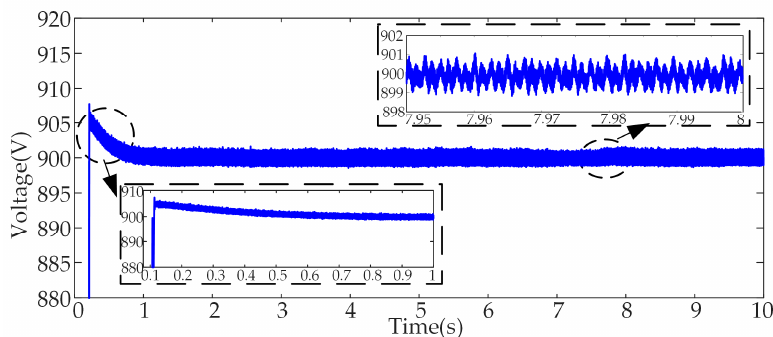
Figure 18. DC bus voltage under irregular incident waves.